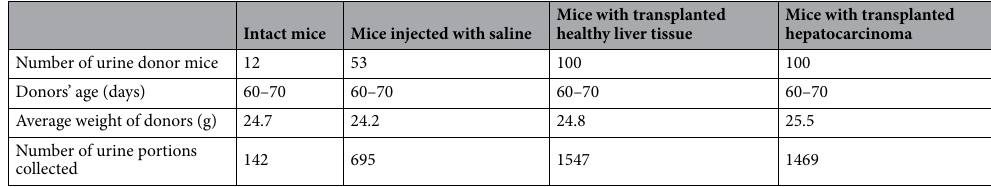
Table 1. The composition of the groups of mice and the number of samples collected for the dog